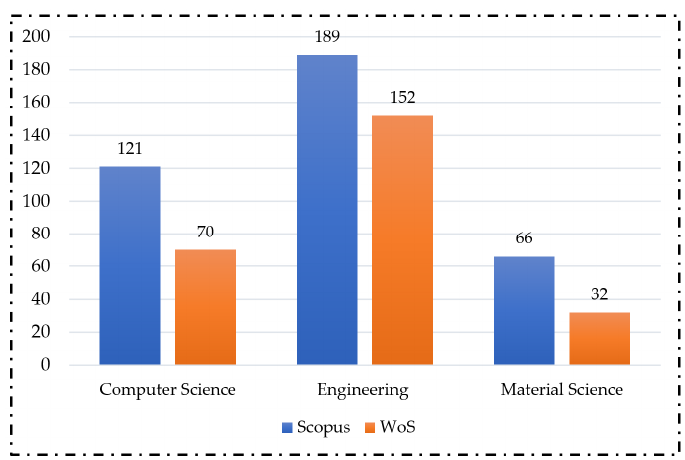
Figure 4. Articles categorization (Scopus vs WoS).